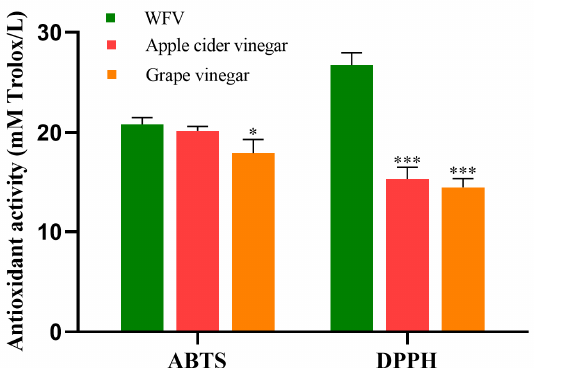
Figure 1. The antioxidant capacity of WFV was measured by ABTS, DPPH assays. The antioxidant capacities of apple cider vinegar, and grape vinegar were cited from Ref. [33]. * p < 0.05, *** p < 0.001 vs. WFV.